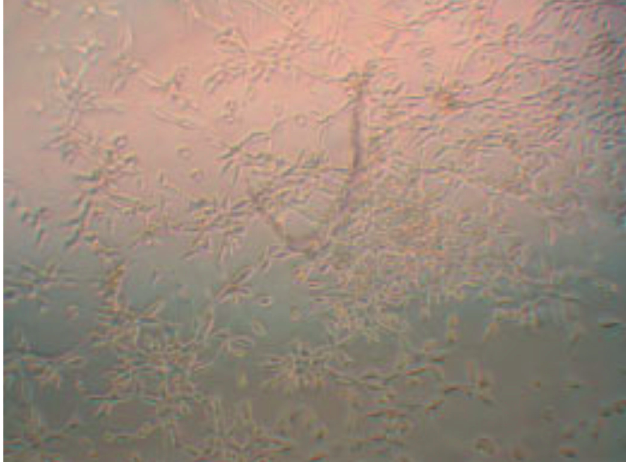
Figure 15. Fibroblast cells attached to the surface of transparent thermosensitive (HMN1) membrane. Reprinted with permission from [24], Copyright © 2004 Wiley-VCH Verlag GmbH & Co. KgaA,